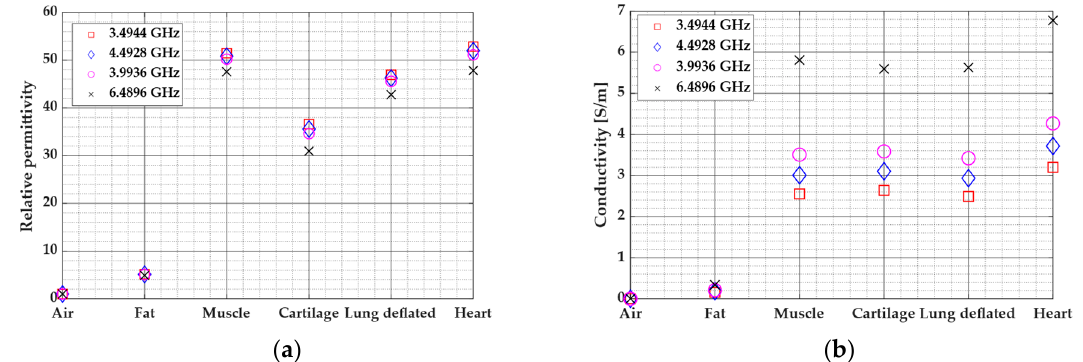
Figure 4. Relative permittivity ε ( a ) and conductivity σ ( b ) through the five tissue layers for the four UWB communication channels with the 3.4944 GHz, 3.9936 GHz, 4.4928 GHz and 6.4896 GHz center frequency with the bandwidth 500 MHz.